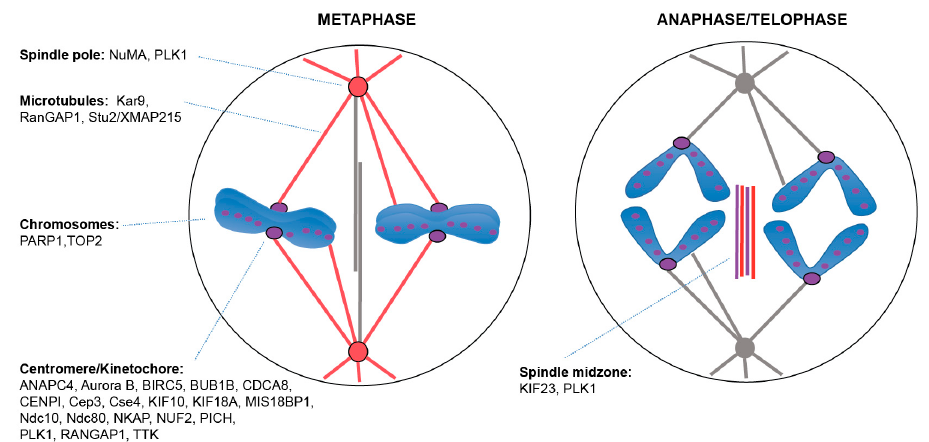
Figure 2. SUMO targets on the mitotic spindle in metaphase (left) and anaphase/telophase (right). In metaphase, SUMO1 (colored in red) mainly localizes around spindle poles and MTs while SUMO2/3 (colored in purple) is enriched at centromeres/kinetochores and around chromosomes. After the metaphase/anaphase transition, SUMO1 relocalizes to the spindle midzone, and SUMO2/3 remains around chromosomes while also localizing to the spindle midzone [36,74]. SUMOylated targets are indicated at the different mitotic locations. Shown are proteins whose SUMOylation has been studied during mitosis. Table 1. List of the SUMOylated spindle proteins for which the function of SUMOylation has been studied in the listed publications and model systems.